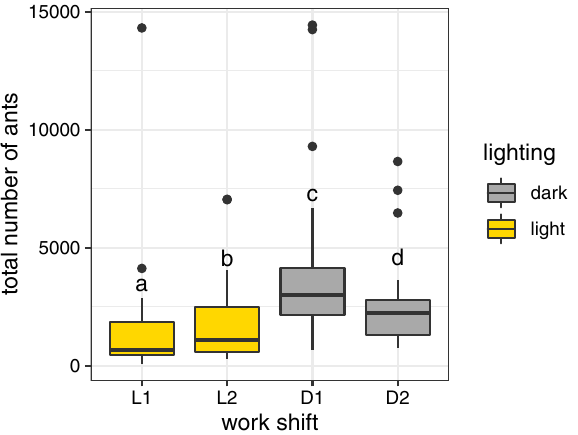
Figure 2. Total ant flow, regardless of marked ants, observed in each work shift for the 5 observation days. Boxplots represents the distribution of marked ants observed for the 5 day period and for the 6 colonies analyzed. Note that ant flow was bigger during night, especially for work shift D1, than day (ant flow KW: χ 2 = 33.324, df = 3, p < 0.001). Letters above boxplots indicate statistically different distributions in a Dunn’s post- hoc test of a Kruskal–Wallis test at p < 0.05.